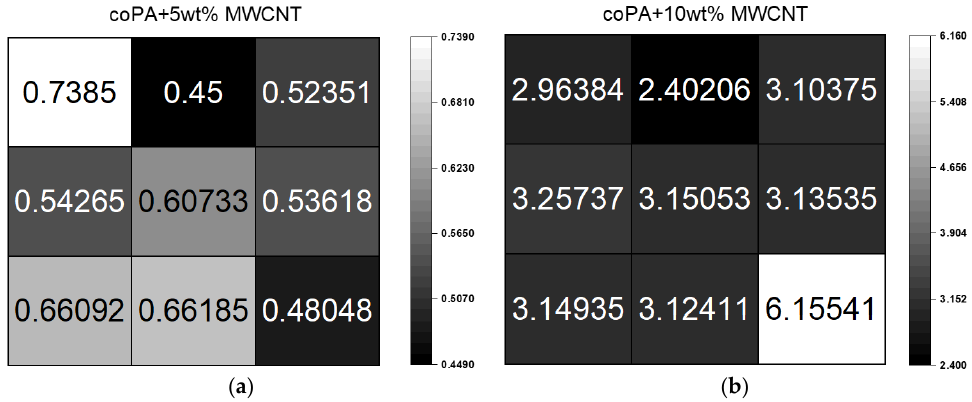
Figure 7. Volume electrical conductivity for masterbatches containing ( a ) 5 wt% and ( b ) 10 wt% MWCNTs.